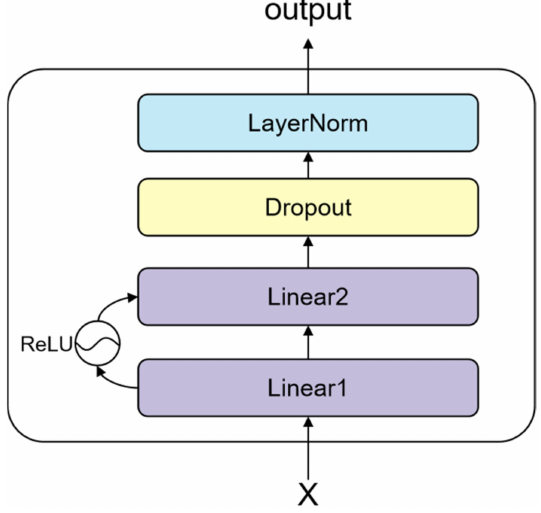
Figure 10. Feed-forward neural network consisting of Linear layers, Dropout layer, and LayerNorm